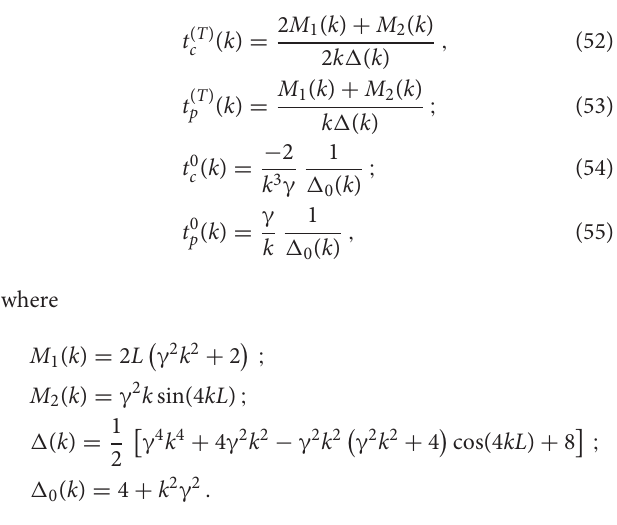
t c O (1 / γ 2 ) and the times essentially overlap for the values of γ used. − ∼